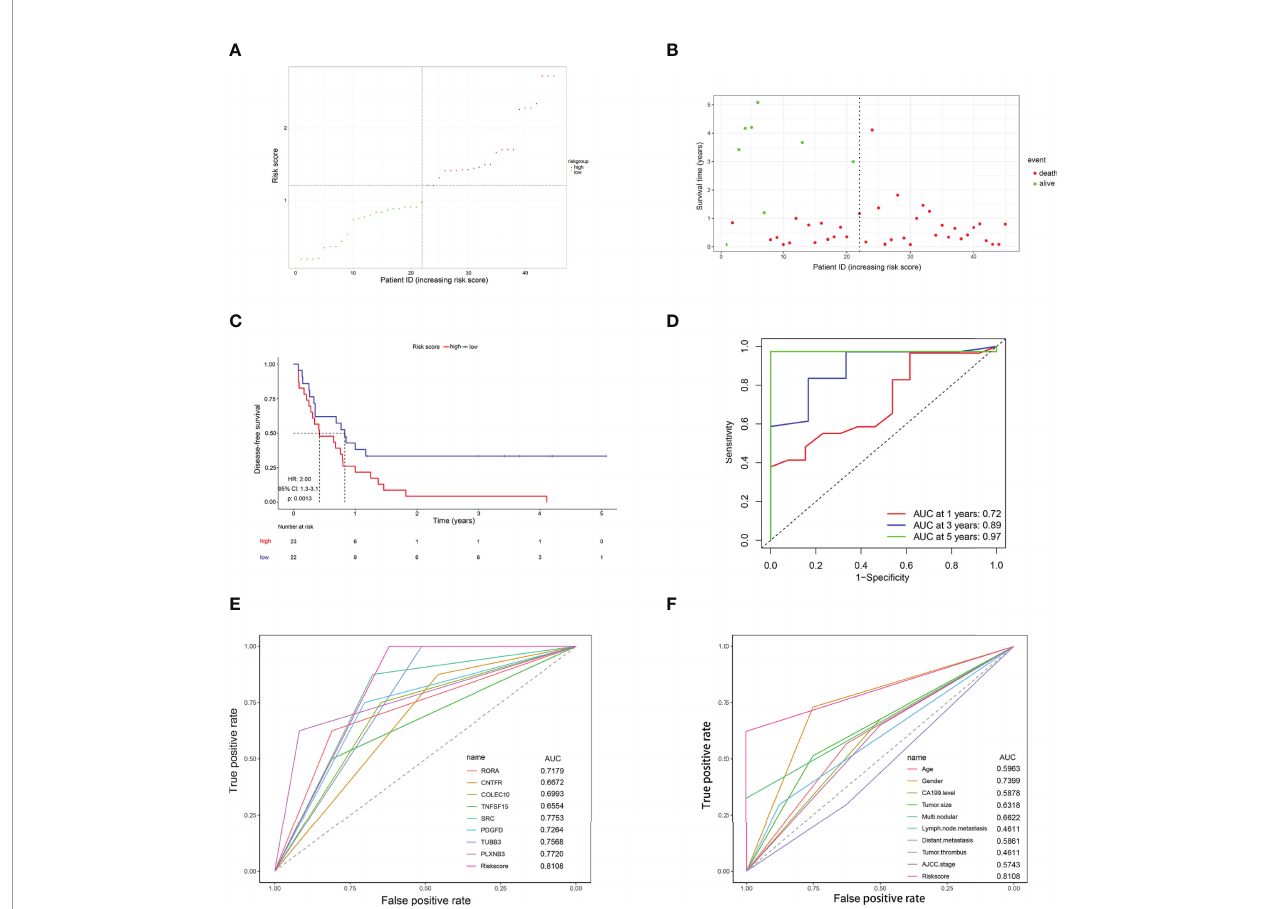
FIGURE 7 | Evaluation of the risk score formula for relapse prediction in the TCGA cohort. (A) Scatter plot for the distribution of risk score and relapse status of individual patients. (B) Survival status of CCA patients in the two 8-IRDEGs signature subgroups. (C) The Kaplan – Meier survival curve of recurrence-free for patients between two different groups. (D) Time-dependent ROC curve at 1, 3, and 5 years. (E) Comparison of prognostic accuracy between the signature and single mRNAs. (F) Comparison of prognostic accuracy between the signature and clinical characteristics. p -values were calculated using the log-rank test. HR, hazard ratio; AUC, area under the ROC curve; RFS, recurrence-free